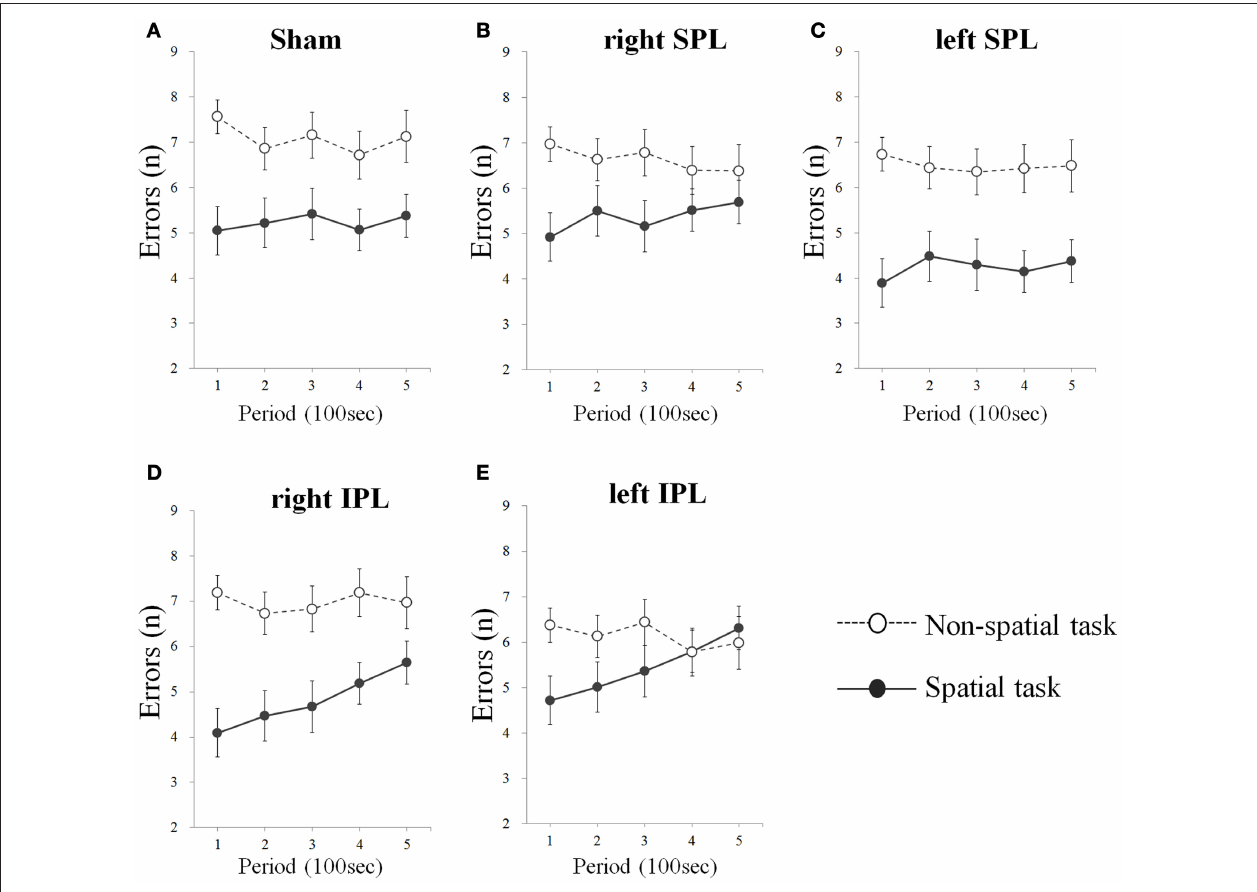
FIGURE 2 | (A–E) Errors over time whilst performing two types of task. Errors were averaged at each period which consists of 20 tests (Error bars indicates SEM). Errors significantly increase on the spatial task when rTMS was performed on the inferior parietal